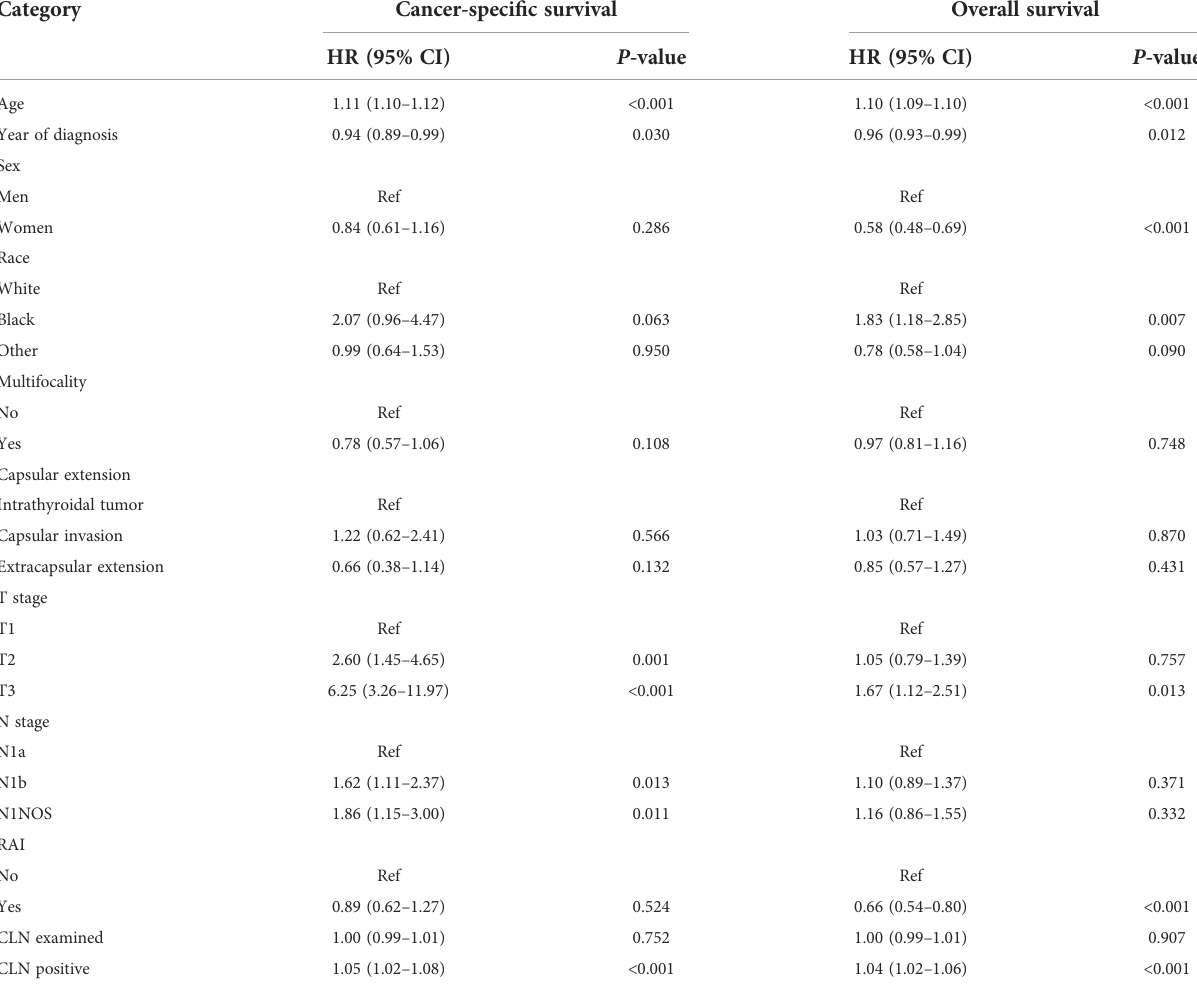
TABLE 2 Multivariate Cox regression analysis for cancer-speci fi c survival and overall survival of PTC